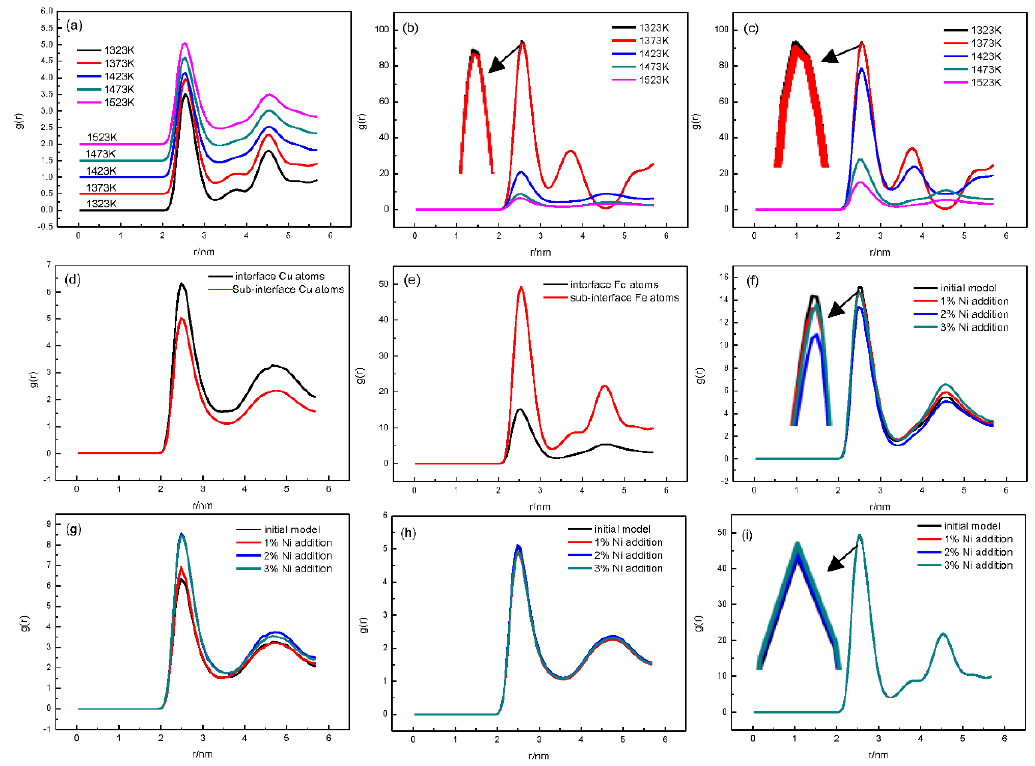
Figure 7. RDFs in different regions of Fe/Cu under different conditions: ( a ) for all atoms in the Fe/Cu interface at different temperatures; ( b ) for interfacial Cu atoms with different temperatures; ( c ) for interfacial Fe atoms with different temperatures; ( d ) for interfacial Cu atoms and sub-interfacial Cu atoms at 1523 K; ( e ) for interfacial Fe atoms and sub-interfacial Fe atoms at 1523 K; ( f ) for interfacial Fe atoms with different nickel contents at 1523 K; ( g ) for interfacial Cu atoms with different nickel contents at 1523 K; ( h ) for sub-interfacial Cu atoms with different nickel contents at 1523 K; ( i ) for sub-interfacial Fe atoms with different nickel contents at 1523 K.